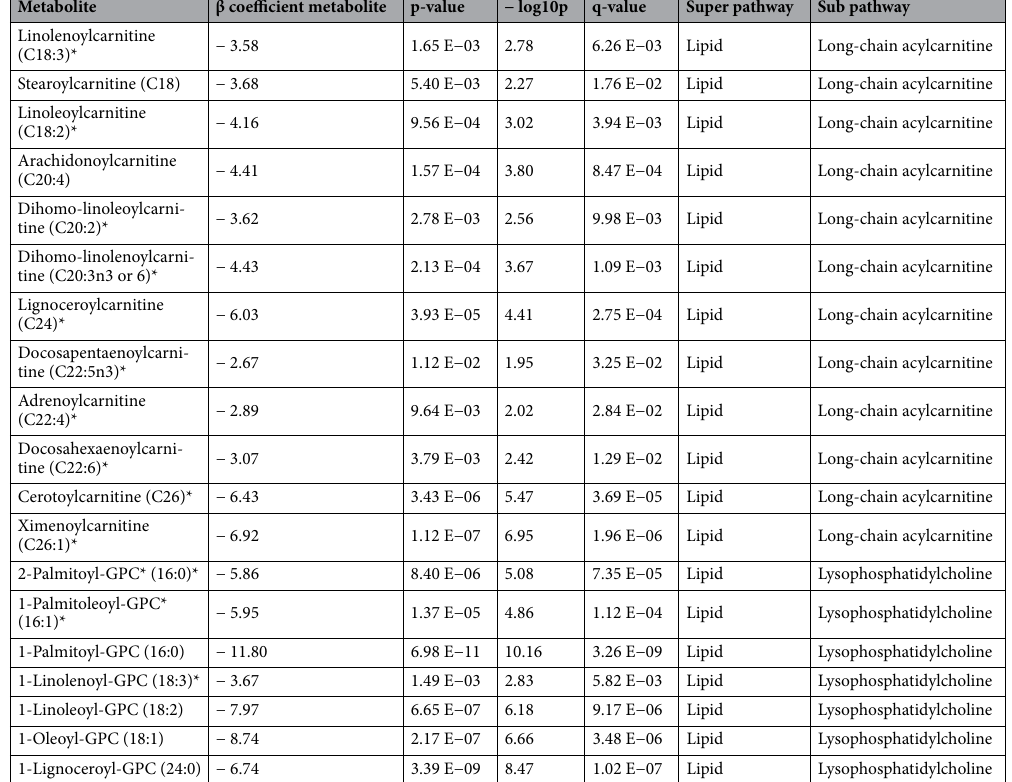
Table 3. Metabolites significantly decreased with increased Procalcitonin over days 0–7. Using repeated measures data (day 0, 3 and 7), the association between relative quantitation of each individual metabolite noted above and Procalcitonin levels over time were determined utilizing linear mixed-effects models correcting for age, sex, baseline 25(OH)D, absolute increase in 25(OH)D, SAPS II, admission diagnosis,